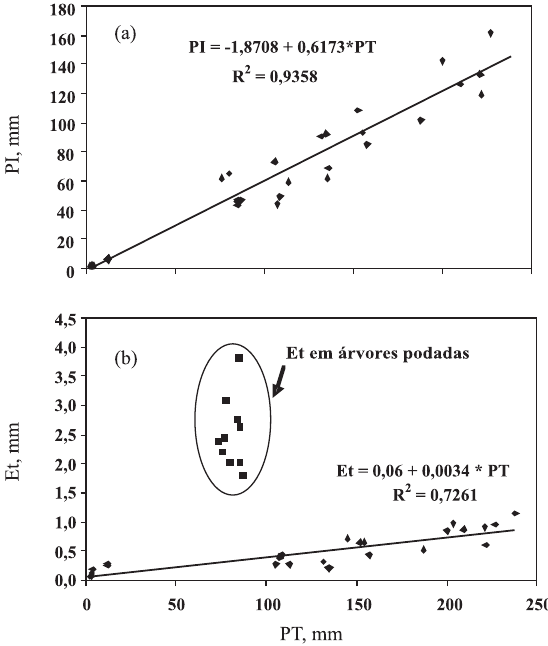
Figura 1. Relações entre precipitação pluvial inter- na (PI) e escoamento pelo tronco com a precipi- tação pluvial total (PT) num sistema agroflorestal de cultivo em aléias com gliricídia, no município de